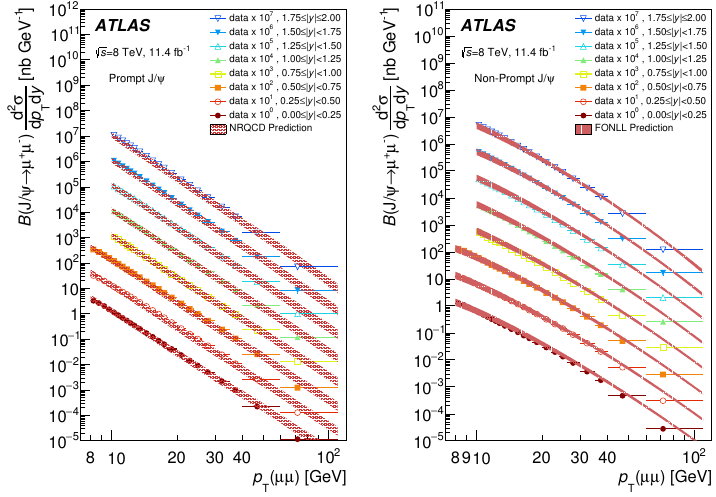
Figure 1. The di ff erential cross-section times dimuon branching fraction for (left) prompt and (right) √ s = 8 TeV as a function of p T in slices of rapidity. Figures are taken non-prompt J /ψ production at from Ref.